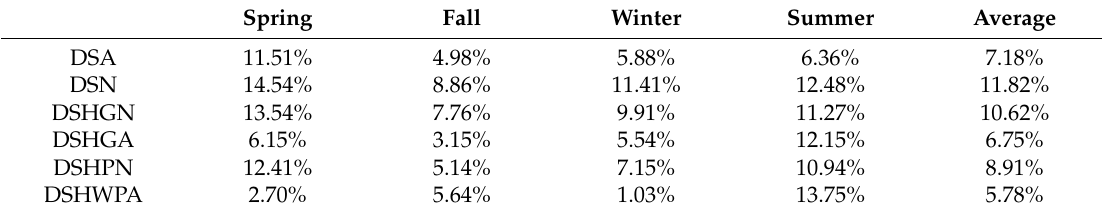
Table 9. Comparison of Results of DSHWPA with DSA, DSN, DSHGN, DSHGA,